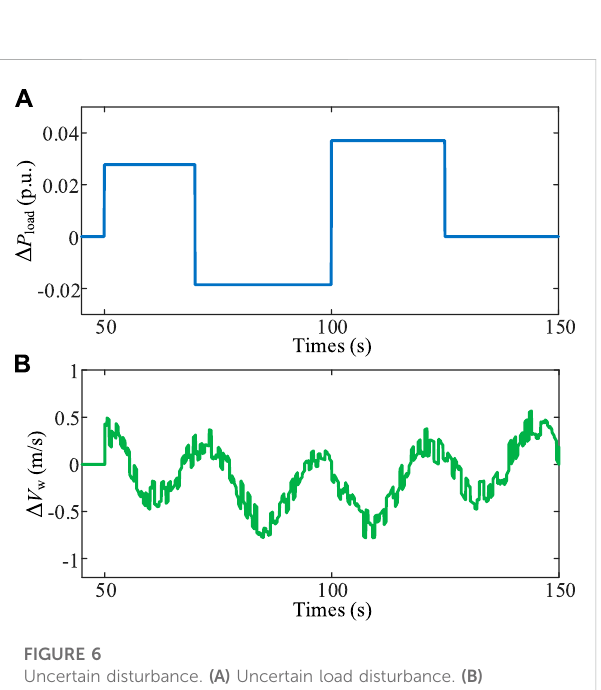
FIGURE 6 Uncertain disturbance. (A) Uncertain load disturbance. (B) Uncertain wind speed